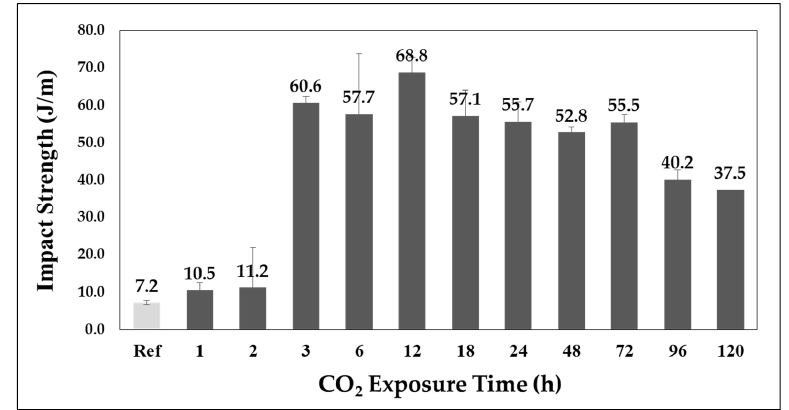
Figure 6. Impact strength of CO 2 dissolved APET.